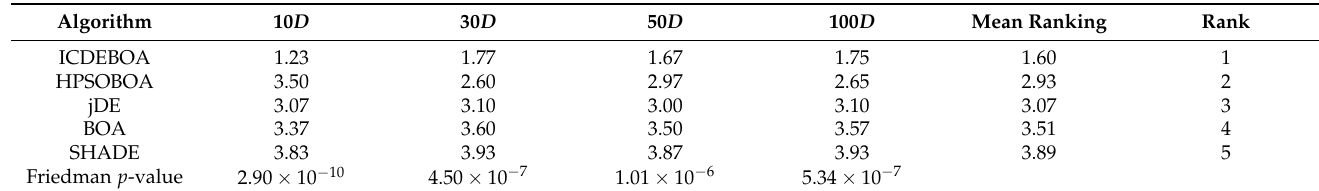
Table 4. Results of the performance comparison using Friedman test with significance α = 0.05 on CEC2014 test